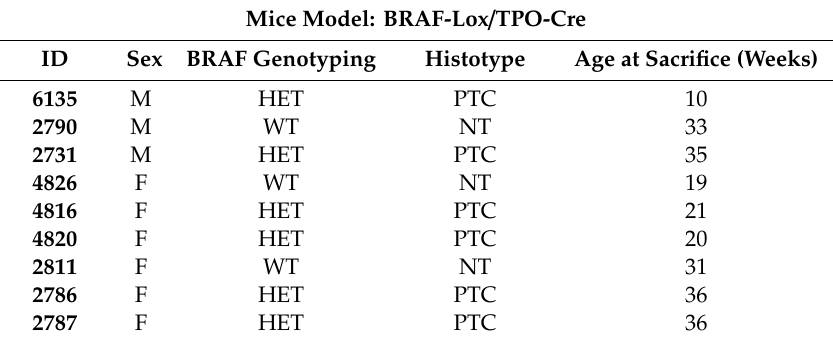
Table 2. Features of analyzed BRAF-Lox / TPO-Cre. HET: heterozygous; WT: wild